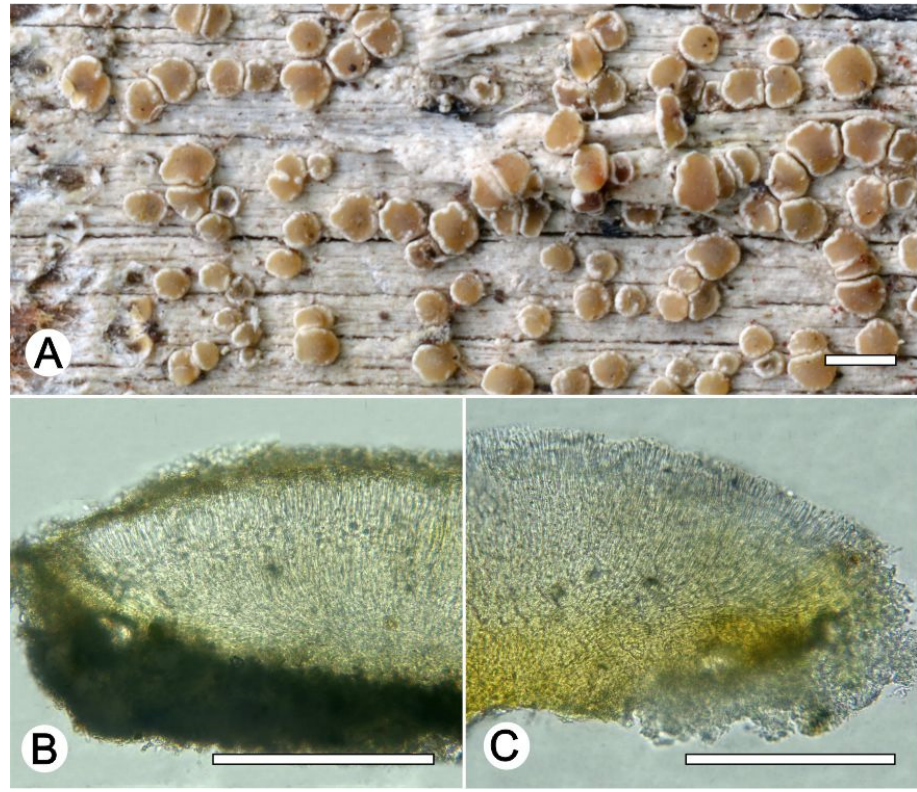
Figure 12. Lecanora saepiphila sp. nov. ( A ) Thallus with ascomata (holotype ISE-42612b); ( B ) Apothecial section in water (holotype ISE-42612b); ( C ) Apothecial section after KOH treatment (holotype ISE-42612b). Scale bars: ( A) , 1 mm; ( B , C ), 100 µm. MycoBank MB